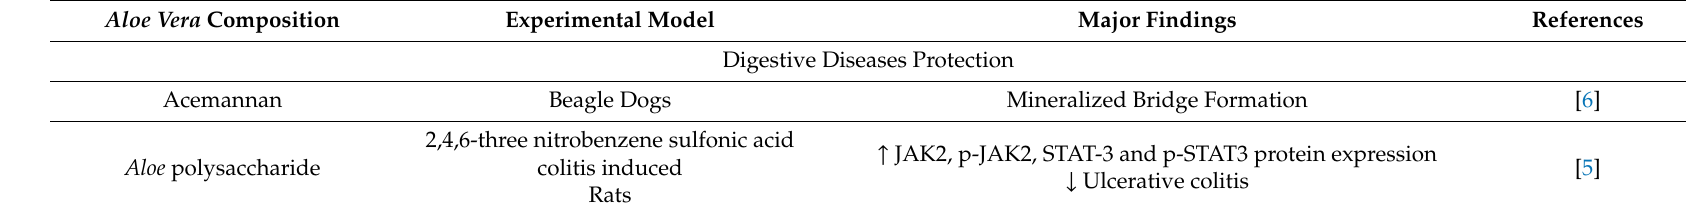
Table 2. In vivo pharmacological studies for Aloe vera